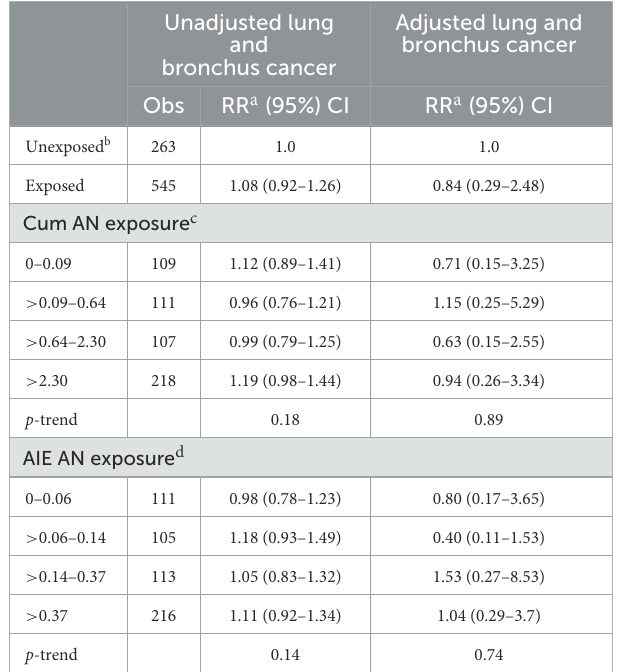
TABLE 6 UPitt lung and bronchus cancer relative risks (RR) in relation to AN exposure adjusted for potential confounding by smoking and by asbestos using the Richardson method, full cohort,